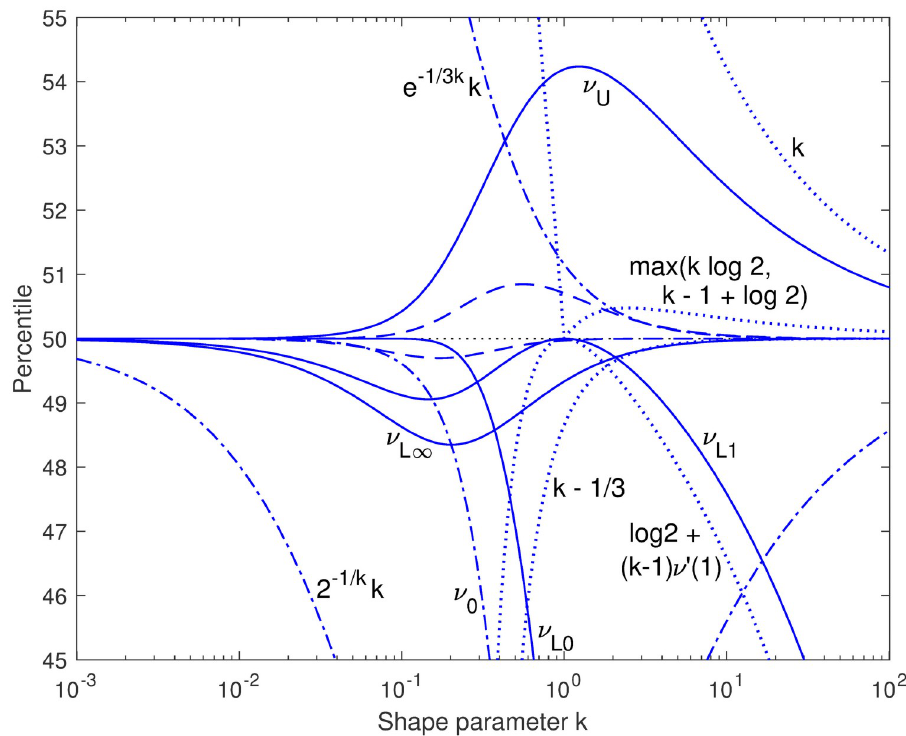
Fig 6. Percentiles achieved. The percentiles achieved by four conjectured median bounds of the form 2 − 1/ k ( A + Bk ) (solid curves) are plotted, along with the straight-line bounds (dotted), upper and lower bounds from Berg and Pedersen [3] (dash-dot), and a pair of closer bounds formed by interpolation between ν U ( k ) and ν L 1 ( k ) using a one- ( k ), ν ( k ), and the interpolated bounds converge on parameter rational function (dashed). The bounds 2 − 1/ k k , ν U L 1 50th percentile at both low and high k , while the other eight do not. Both the upper and lower interpolated bounds are close to ν U ( k ) at low k and close to ν L 1 ( k ) at high k ; tighter such interpolated bounds, developed in a later section, would crowd the center of the